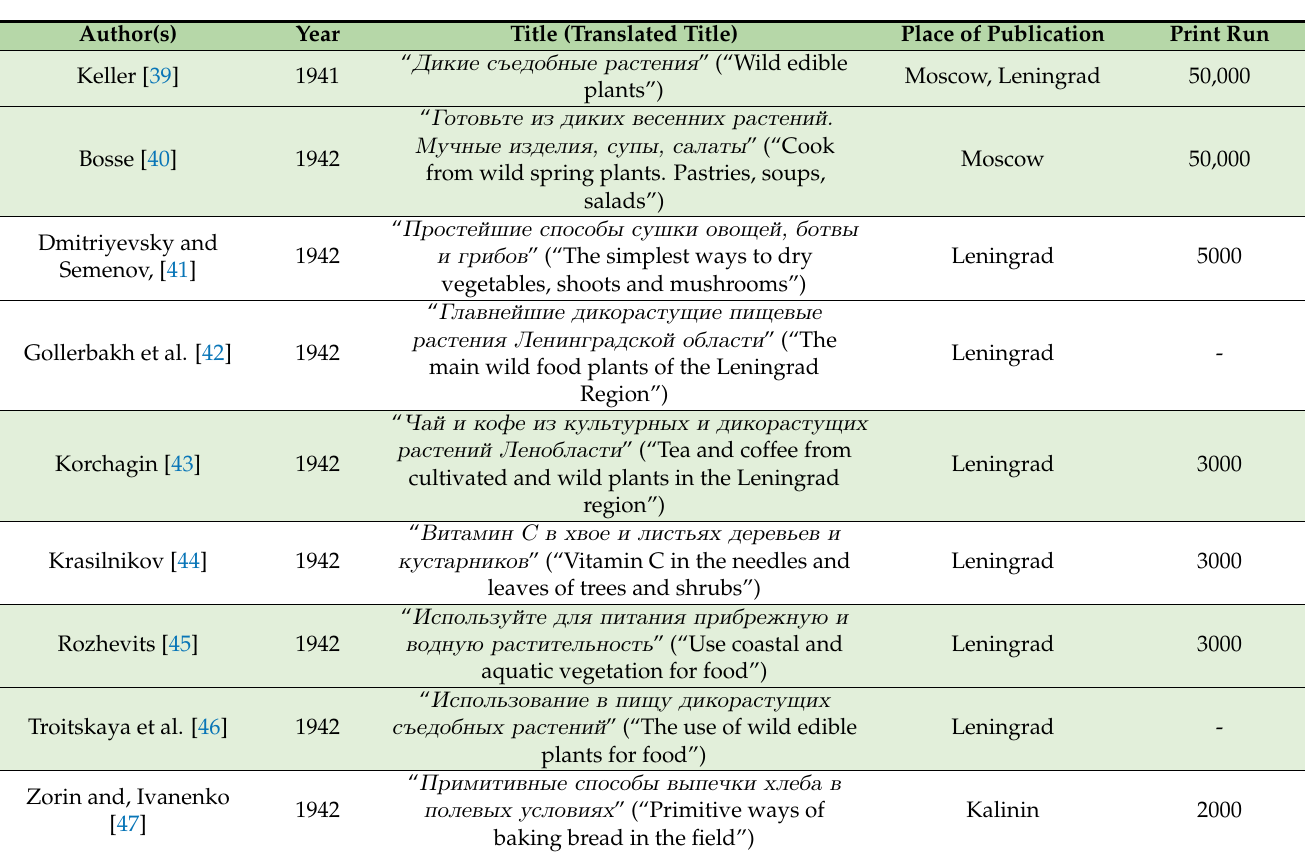
Table 1. Books on wild food plant use published in the Soviet Union. Highlighted in green are the books used for this